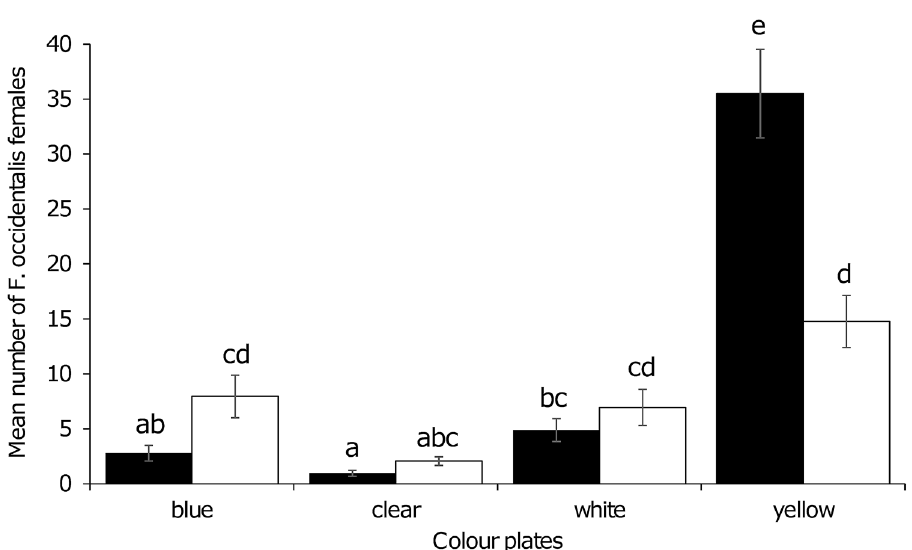
Figure 5. Mean number of Frankliniella occidentalis caught on coloured plates with Stikem glue (white bars) or D41 glue (black bars) in a wind tunnel (N = 18). Different letters (a, b, c, ….) above the bars indicate significantly different values at P < 0.05. Error bars represent standard error